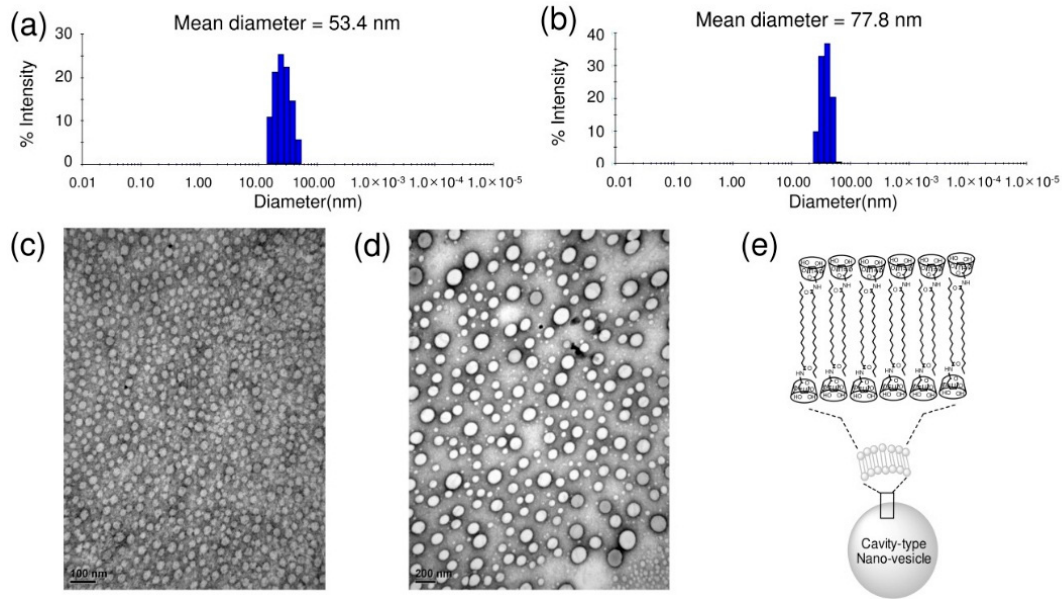
Figure 5. DLS profiles. ( a ) S- β -CD; ( b ) O- β -CD. TEM images; ( c ) S- β -CD (scale bar = 100 nm); ( d ) O- β -CD (scale bar = 200 nm); and ( e ) illustration of the self-assembled nano-structure by S- β -CD in water.